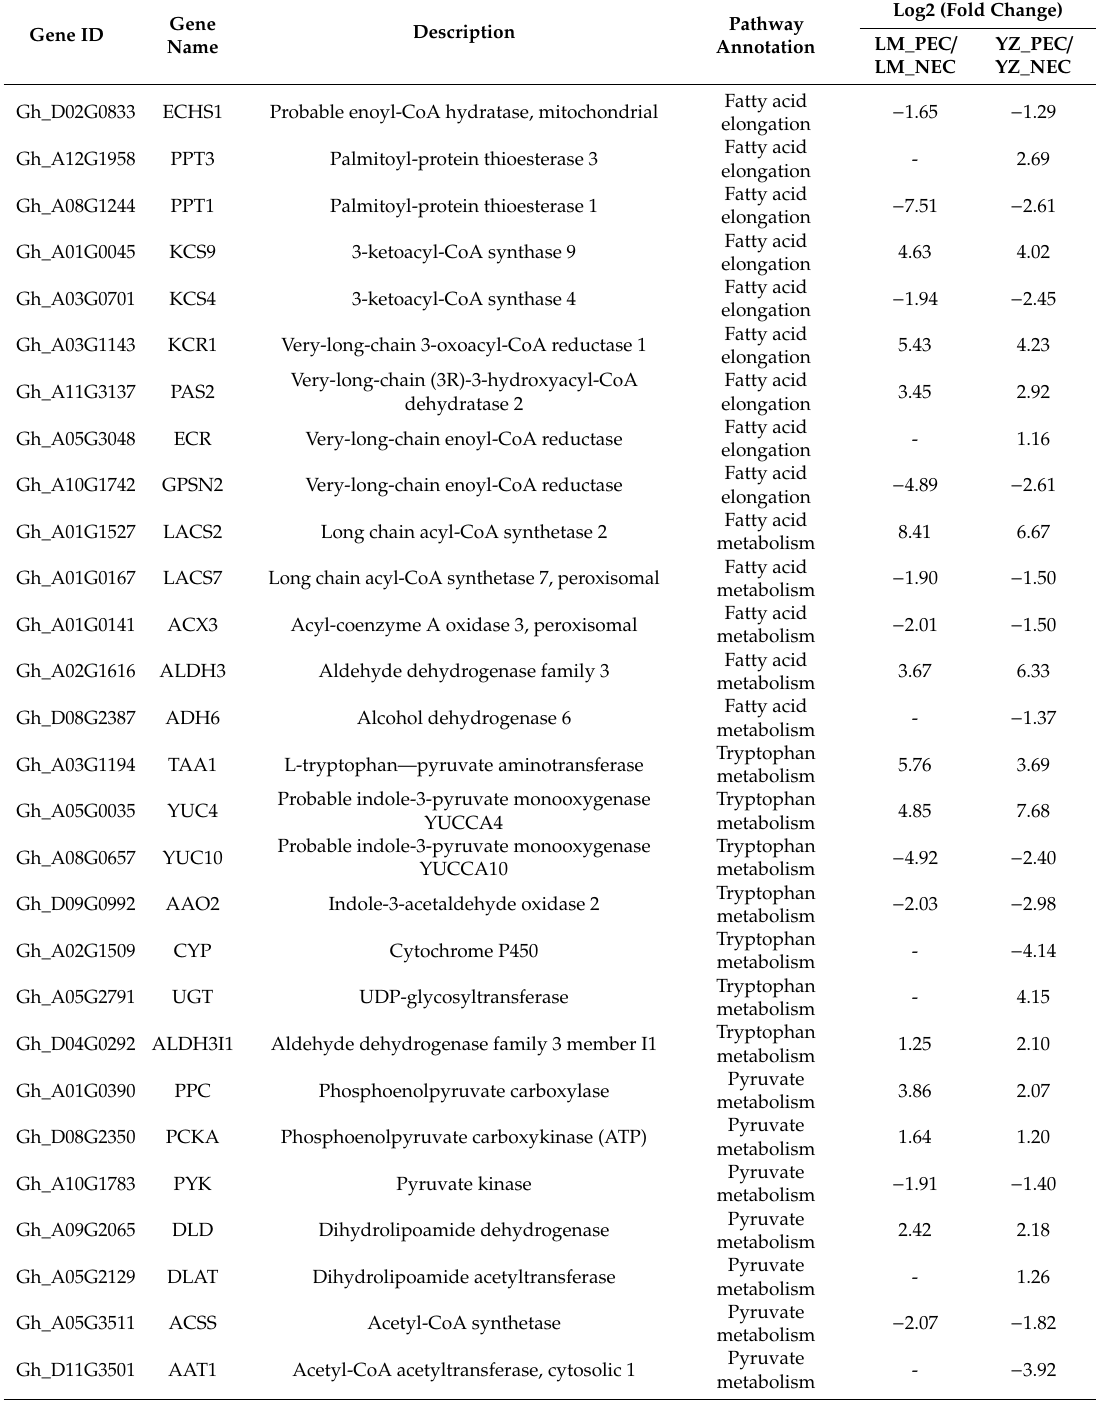
Table 2. Significantly representative SE-related DEGs enriched in fatty acid, tryptophan and pyruvate metabolism during embryogenic transdi ff